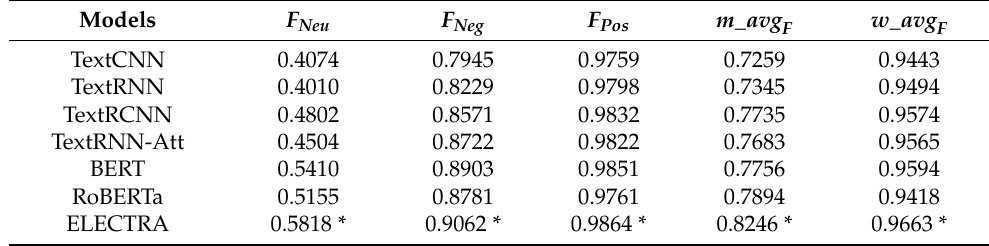
Table 2. Experimental results of performance